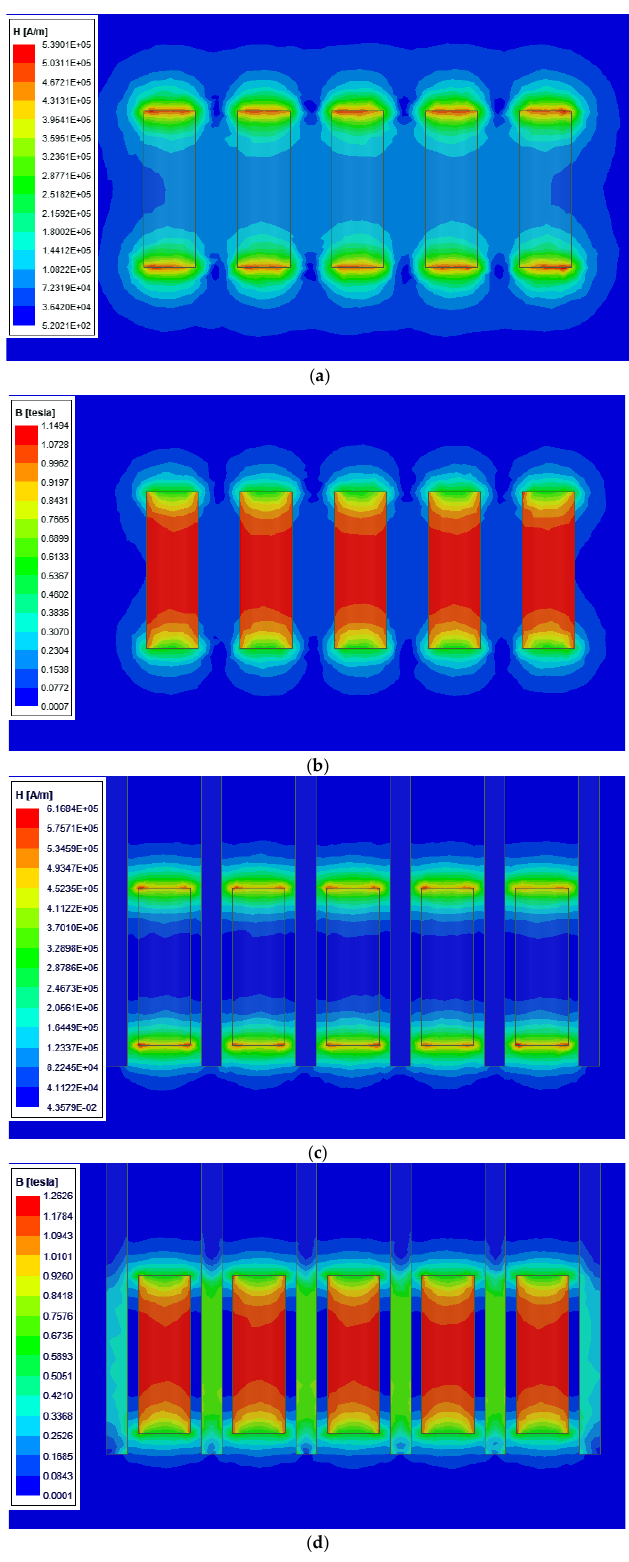
Figure 9. Magnetic field simulation results. ( a ) Cloud diagram of magnetic field distribution of permanent magnet array. ( b ) Cloud diagram of magnetic induction distribution of permanent magnet array. ( c ) Cloud diagram of magnetic field distribution of permanent magnet silicon steel array. ( d ) Cloud diagram of magnetic induction distribution of permanent magnet silicon steel array.